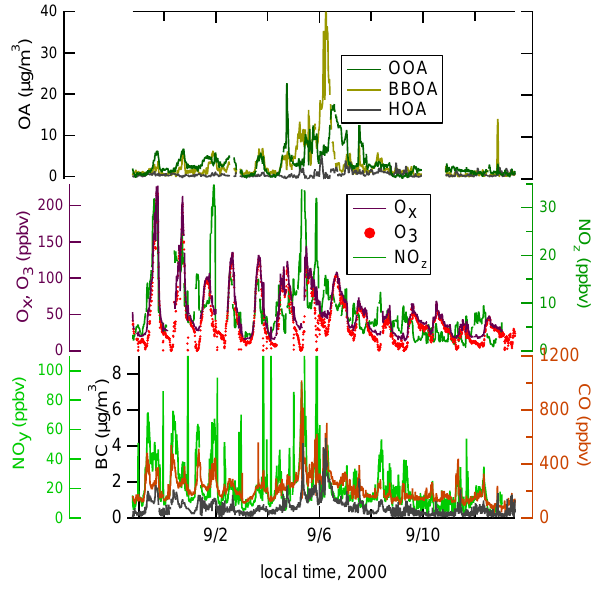
Fig. 2. Time series at La Porte, TX in 2000.